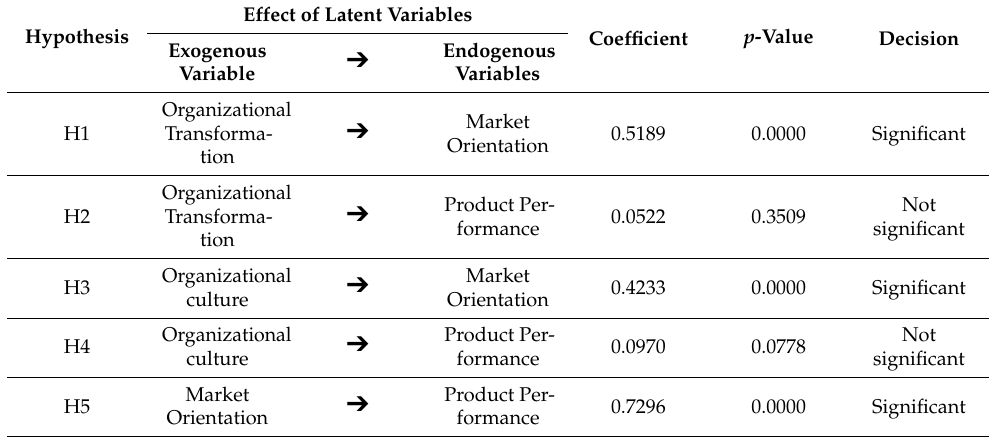
Table 3. Results of the Inner Hypothesis Testing of the WarpPLS SEM